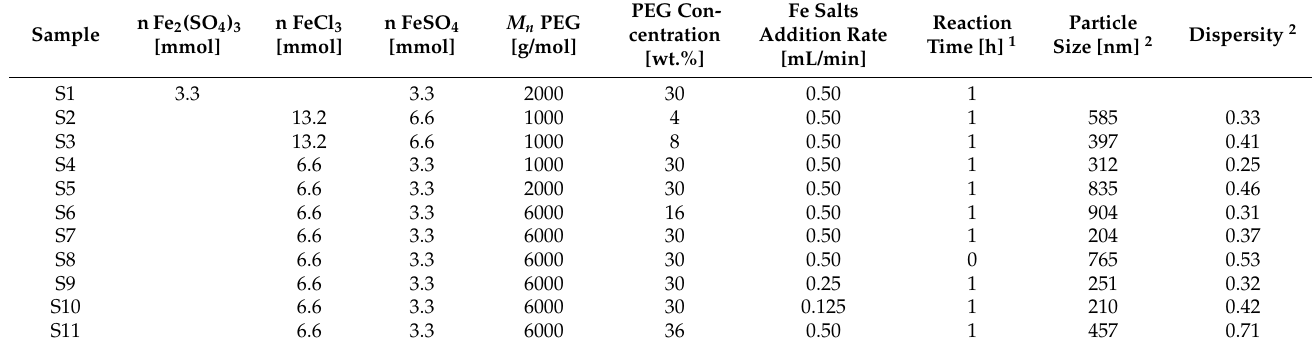
Table 4. The synthesis of